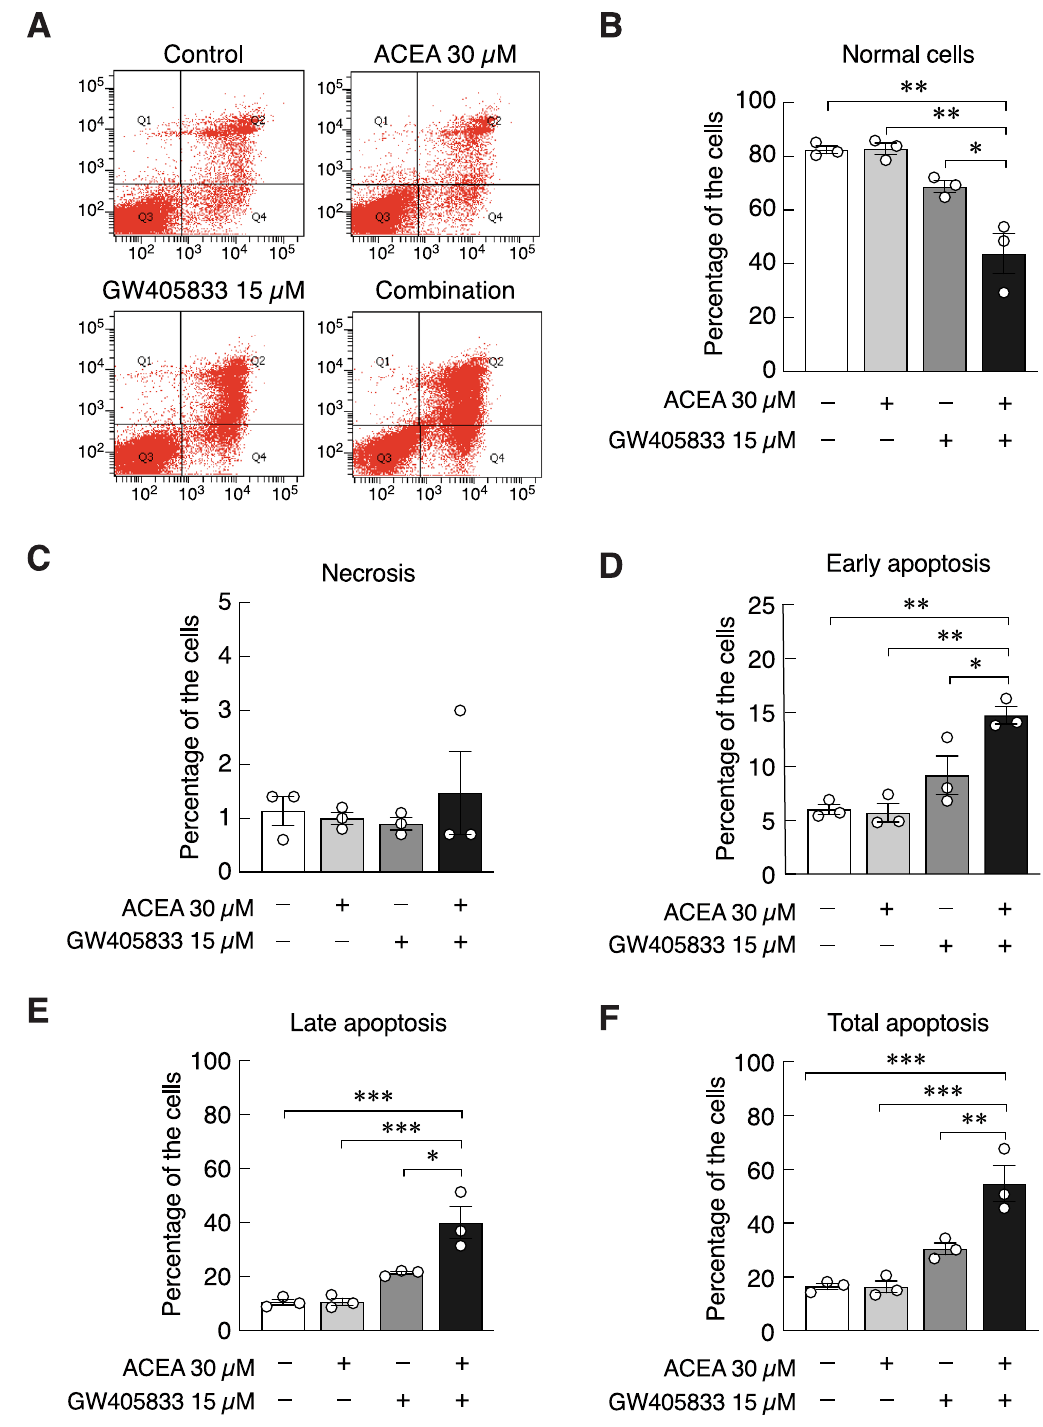
Figure 5. Combining effects of ACEA and GW405833 induced apoptosis in MDA-MB-231 cells ( a ) Apoptotic cell death in cells treated for 48 h with 30 µM ACEA, 15 µM GW405833, or a combination of both agents was analyzed by flow cytometry using Annexin-V-FITC and PI double staining. Quantified data of ( b ) normal cells, ( c ) necrosis, ( d ) early apoptosis, ( e ) late apoptosis and ( f ) total apoptosis, after treatment with CB receptor agonists were shown. Bar graphs represent mean ± SEM of three independent biological experiments. (*** p < 0.001, ** p < 0.01, * p <